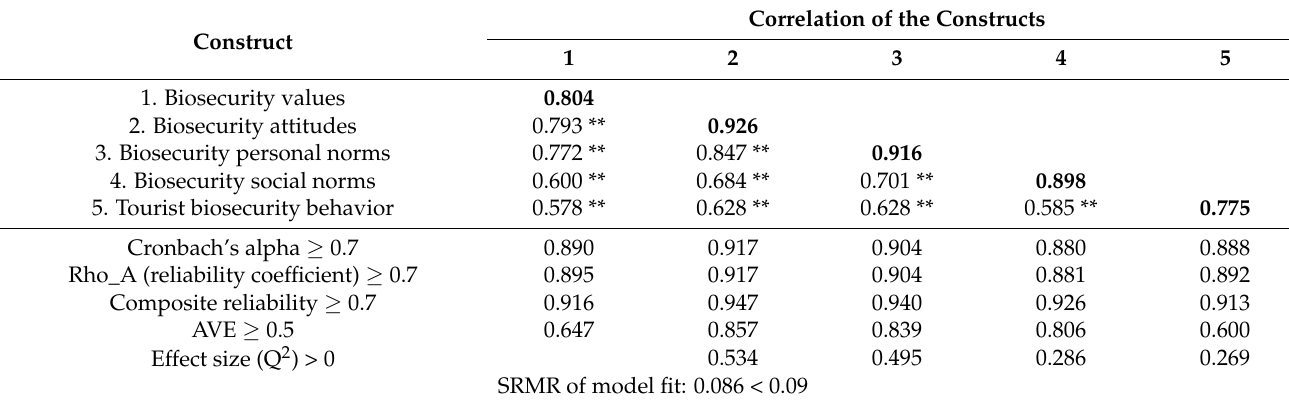
Table 4. Reliability and discriminant